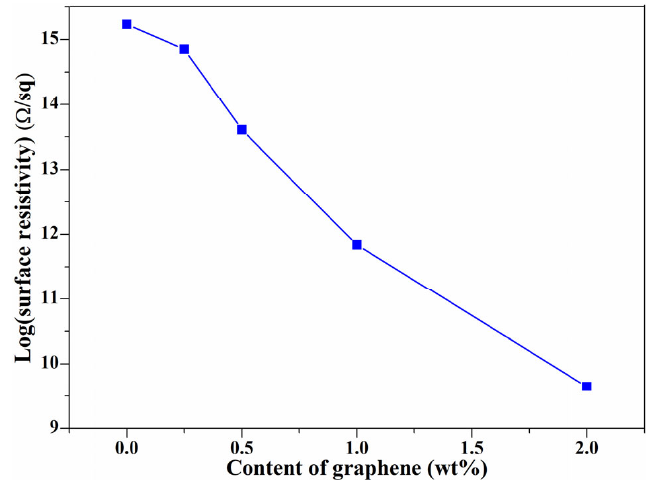
Figure 4. Surface resistivity of PE and graphene/PE composites.